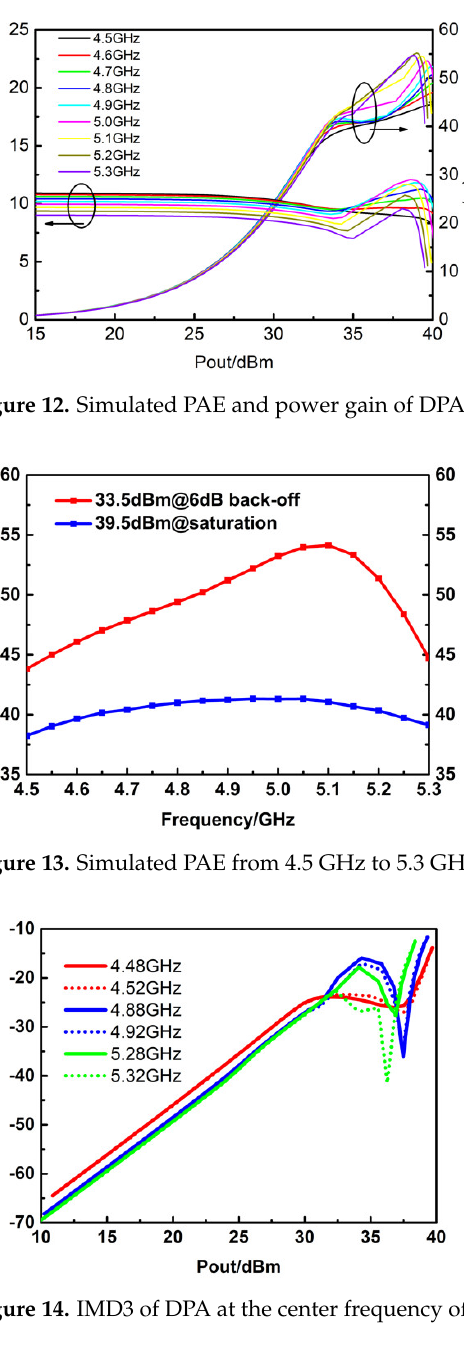
Figure 15. Layout of the DPA. 4. Conclusions An ultra-compact two-way asymmetrical Doherty power amplifier based on a 0.25 um GaN HEMT MMIC process is presented in the paper. The high gain has been obtained with the asymmetrical Doherty, which has a 2.5:1 power ratio for the main and auxiliary PA. In addition, IMNs with phase compensation function have been introduced to reduce the size of the circuit. For a broadband operation, a novel topology with low ITR has been employed to alleviate the bandwidth limiting factor caused by the quarter-wavelength transformer. With the design concept, the simulated result shows that the proposed circuit achieves a small-signal gain of 11 dB, a 6-dB back-off PAE of 38–41.3%, a saturation PAE